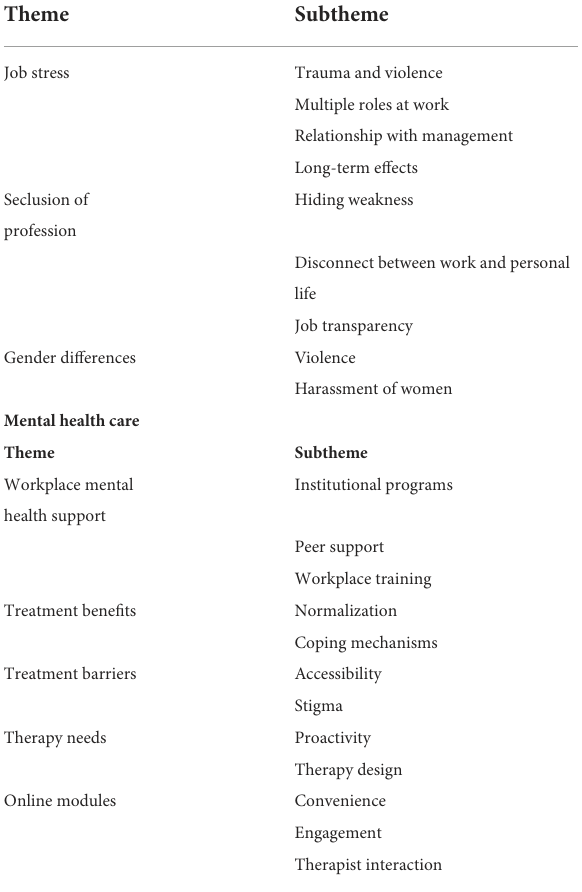
TABLE 3 Summary of gender-specific focus group